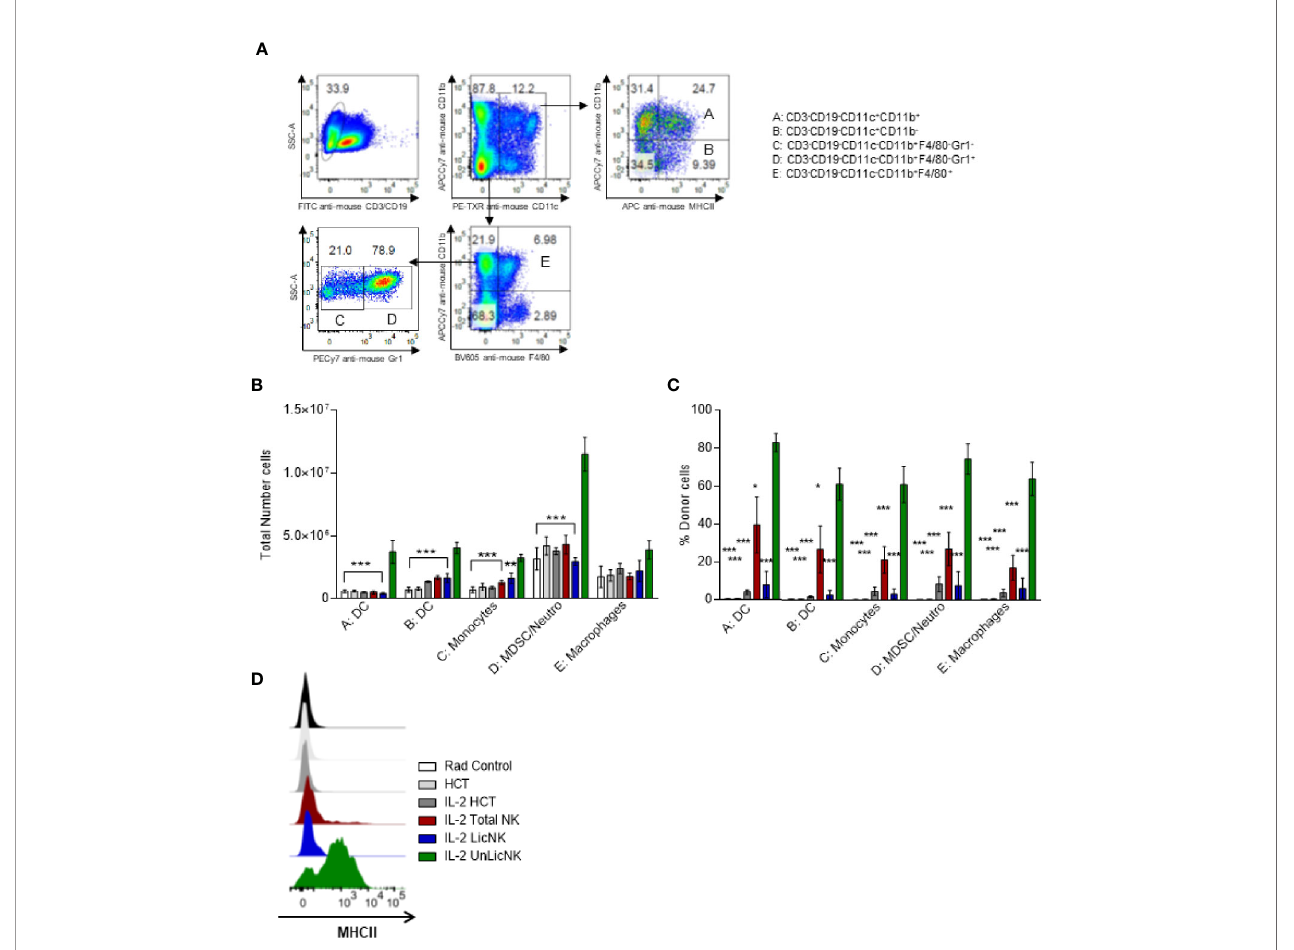
FIGURE 5 | Impact of the early presence of host type activated UnLicNK cells after NMAC allogeneic HCT for myeloid cell reconstitution. (A) Representative Pseudo-color-plots for the gating strategy to differentiate the myeloid cell compartment. (B) The total number of myeloid-derived DC (CD3 - CD19 - CD11c + CD11b + ), CD11b - DC (CD3 - CD19 - CD11c + CD11b - ), monocytes (CD3 - CD19 - CD11c - CD11b + F4/80 - Gr1 - ), MDSC/neutrophils (CD3 - CD19 - CD11c - CD11b + F4/80 - Gr1 + ) and macrophages (CD3 - CD19 - CD11c - CD11b + F4/80 + ) is shown. (C) The percentage of H2Dd + cells is shown for each type described in (C , D) . (D) Representative histograms for the expression of MHCII on myeloid-derived DCs. Data is representative of two independent experiments with n=3-5 per group (mean ± SEM). One-way ANOVA or Two-Way ANOVA was used to assess signi fi cance (*p<0.05, **p<0.01,